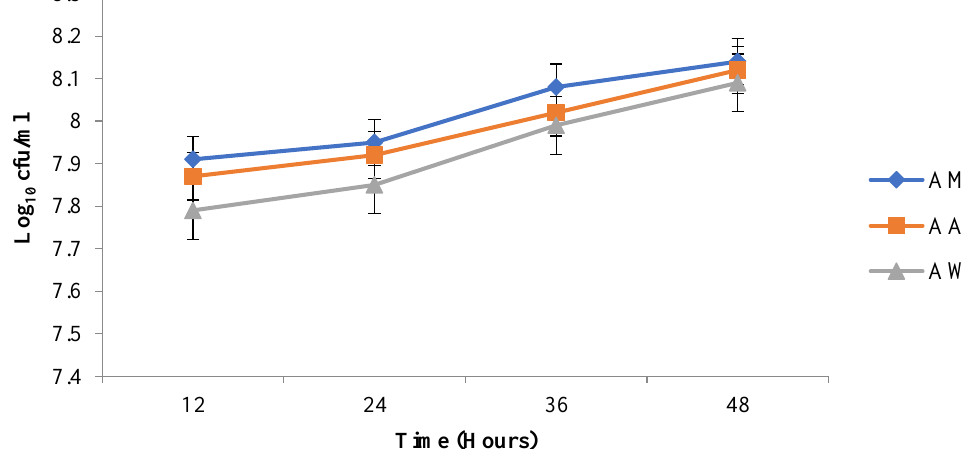
Figure 8. The growth rate of L. fermentum in the synbiotic beverages increased over a 48 h period.